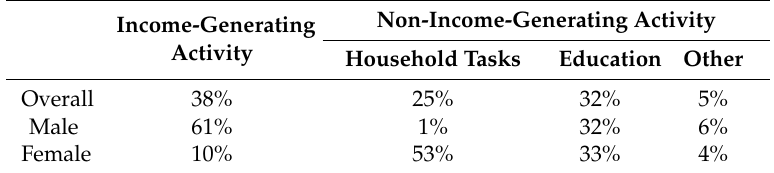
Table 1. Percentage distribution of survey respondents and their income status by gender.